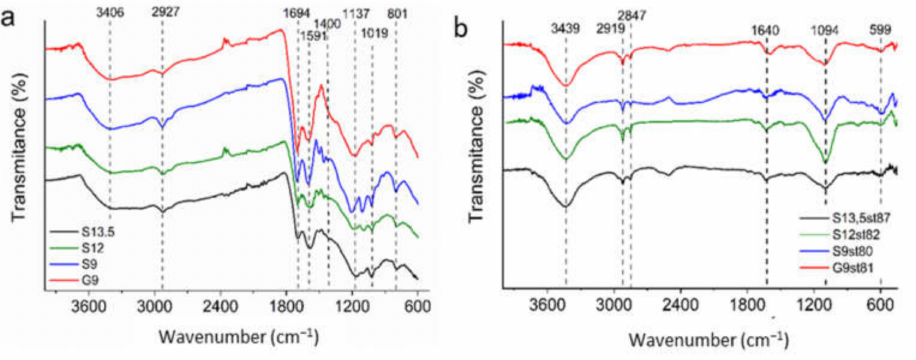
Figure 7. FTIR spectra of acid-chars ( a ) and derived activated carbons ( b )